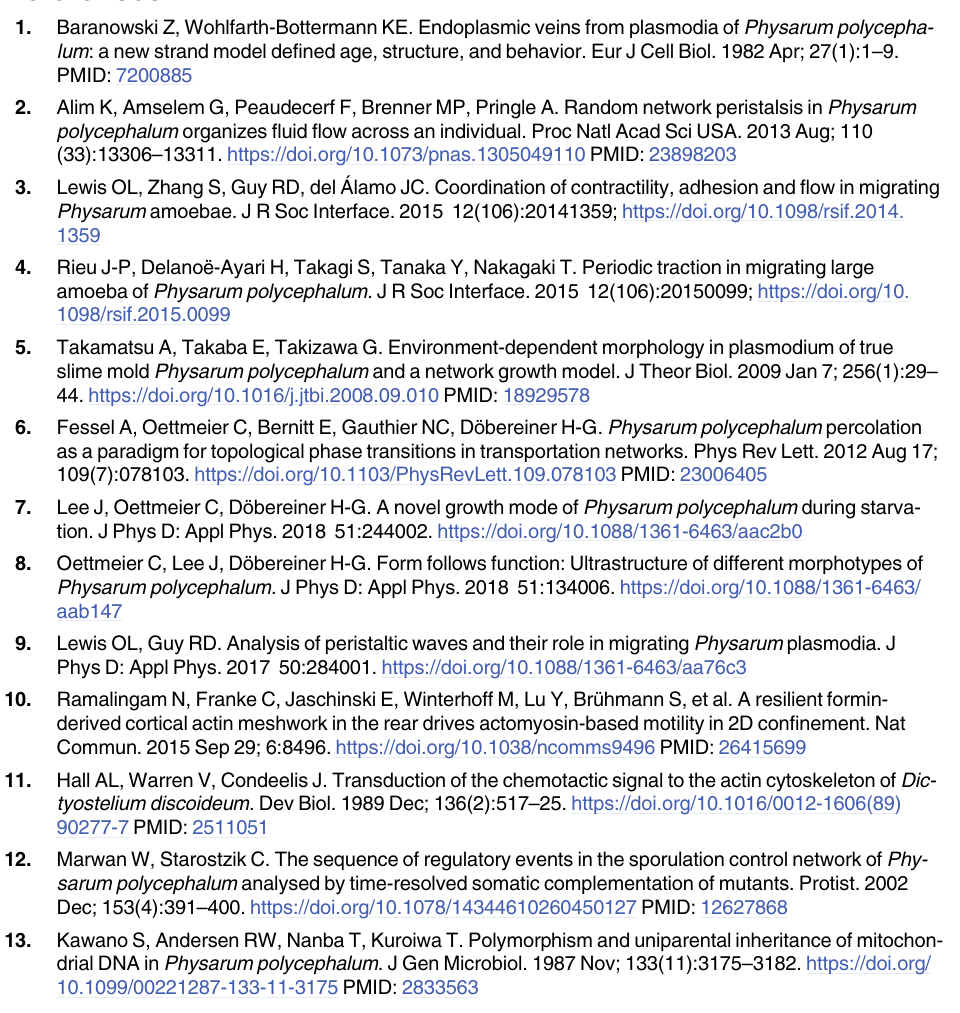
S3 Fig. Circularity and frontal membrane velocity over time. Phases of high circularity cor- respond to a slowing of locomotion. (TIFF) S1 Movie. Video of a mesoplasmodium showing frequency